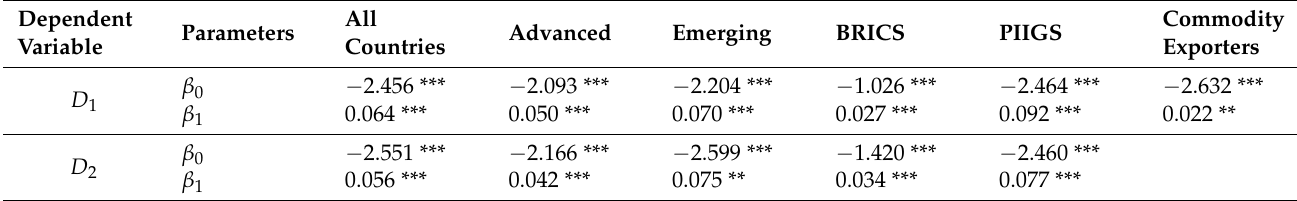
Table 2. Estimates of the Probit